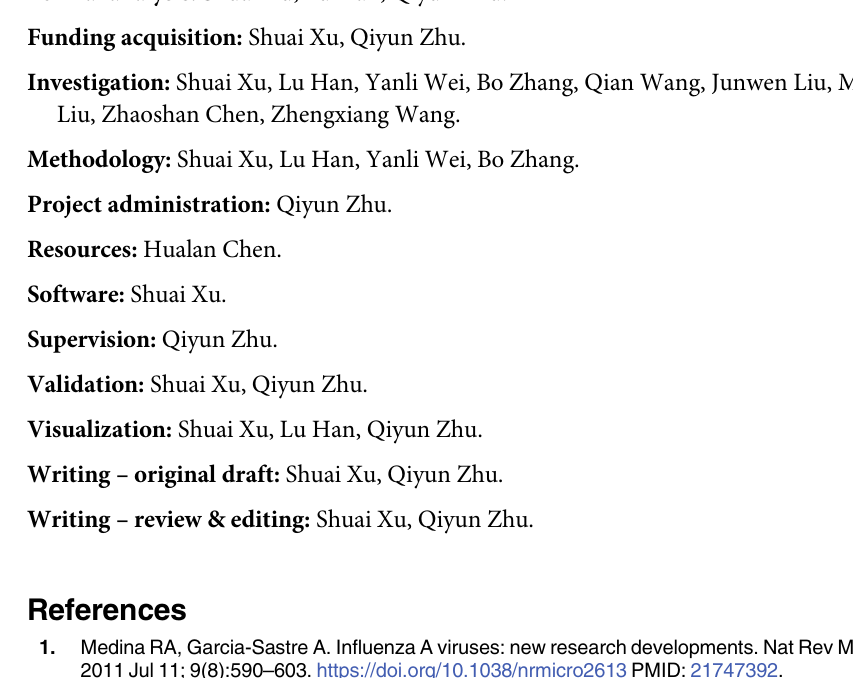
S2 Table. PCR primers used in this